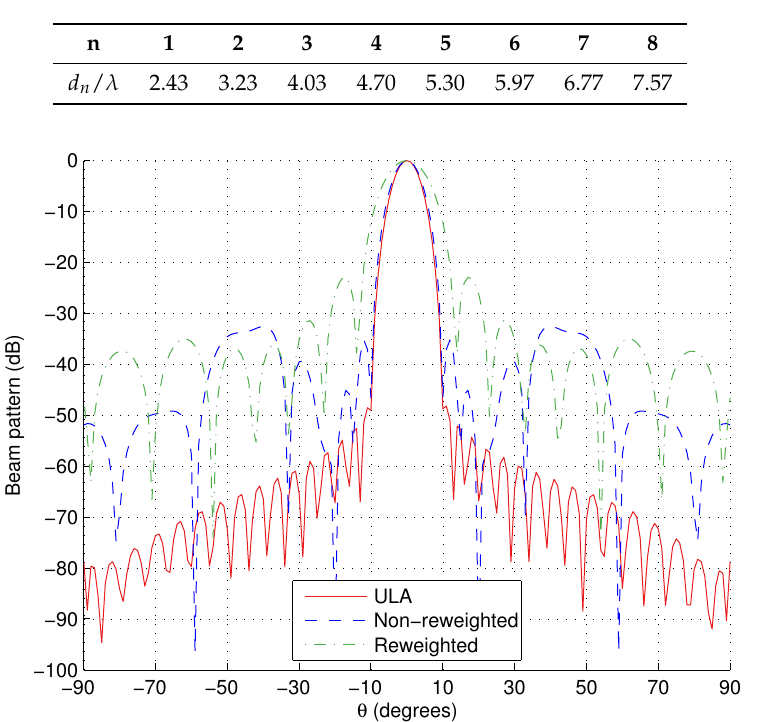
Table 3. Locations for the reweighted broadside design example, M = 301.